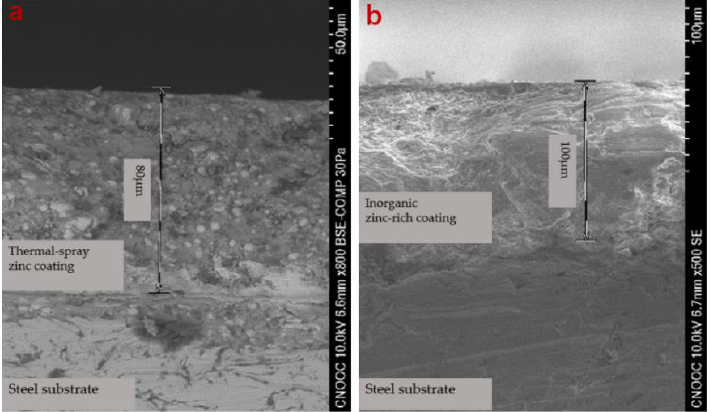
Figure 4. Analysis of the cross-sectional microstructure of the zinc coating: ( a ) thermal-spray zinc coating and ( b ) inorganic zinc-rich coating.